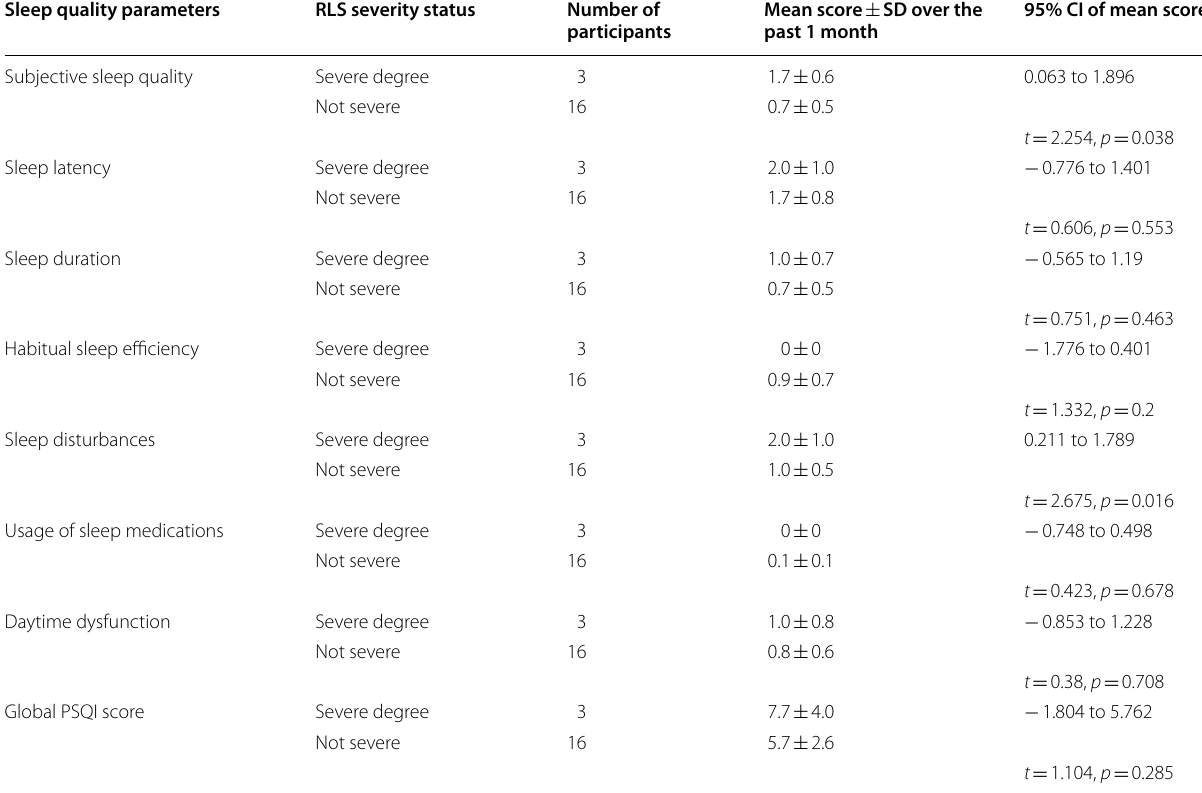
Table 5 Association between restless leg syndrome (RLS) severity status and quality of sleep among the newly diagnosed participants with RLS ( n =